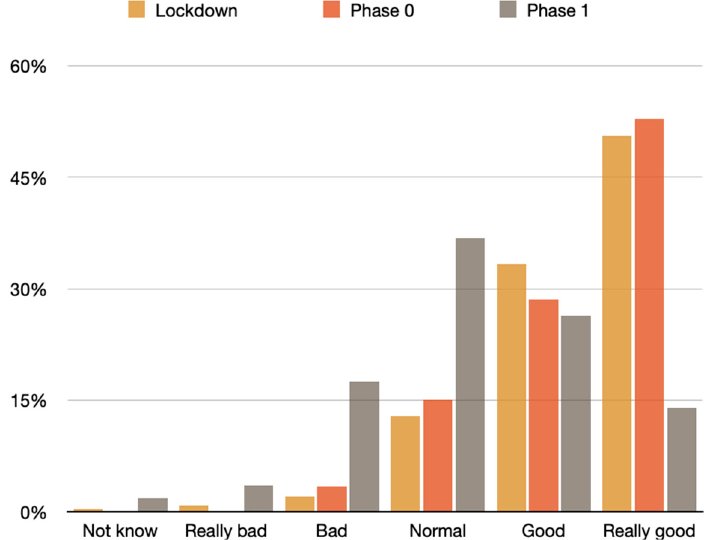
Figure 11. Sound quality during lockdown, phase 0 and phase 1.